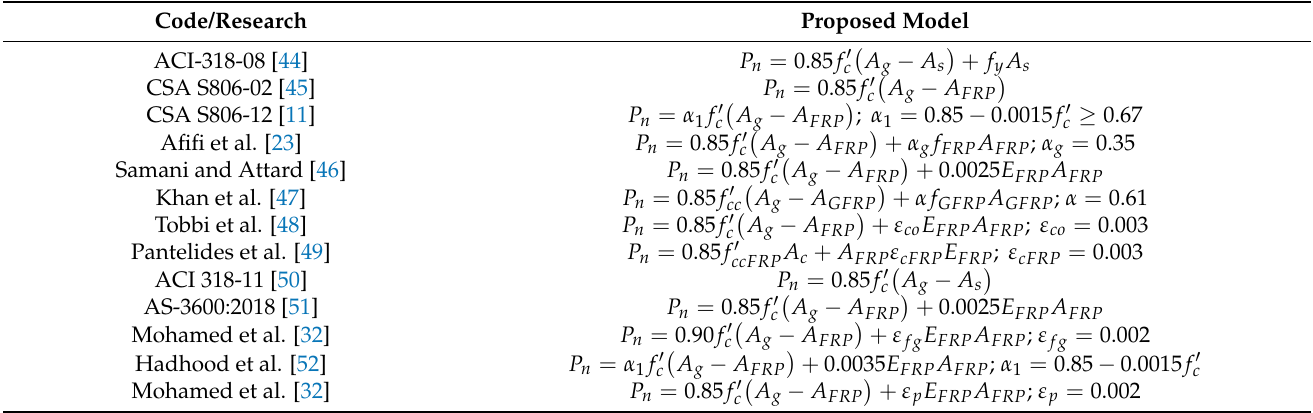
Table 2. Axial strength (AS) models for